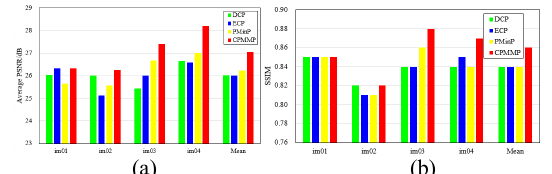
Figure 5. Quantitative evaluations of the benchmark dataset. (a) PSNR. (b) SSIM.